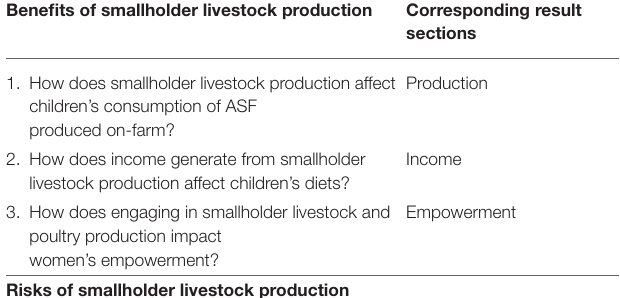
TABLE 1 | Research questions on benefits and risks of smallholder livestock production on child nutrition in low- and middle- income countries (LMIC). Benefits of smallholder livestock